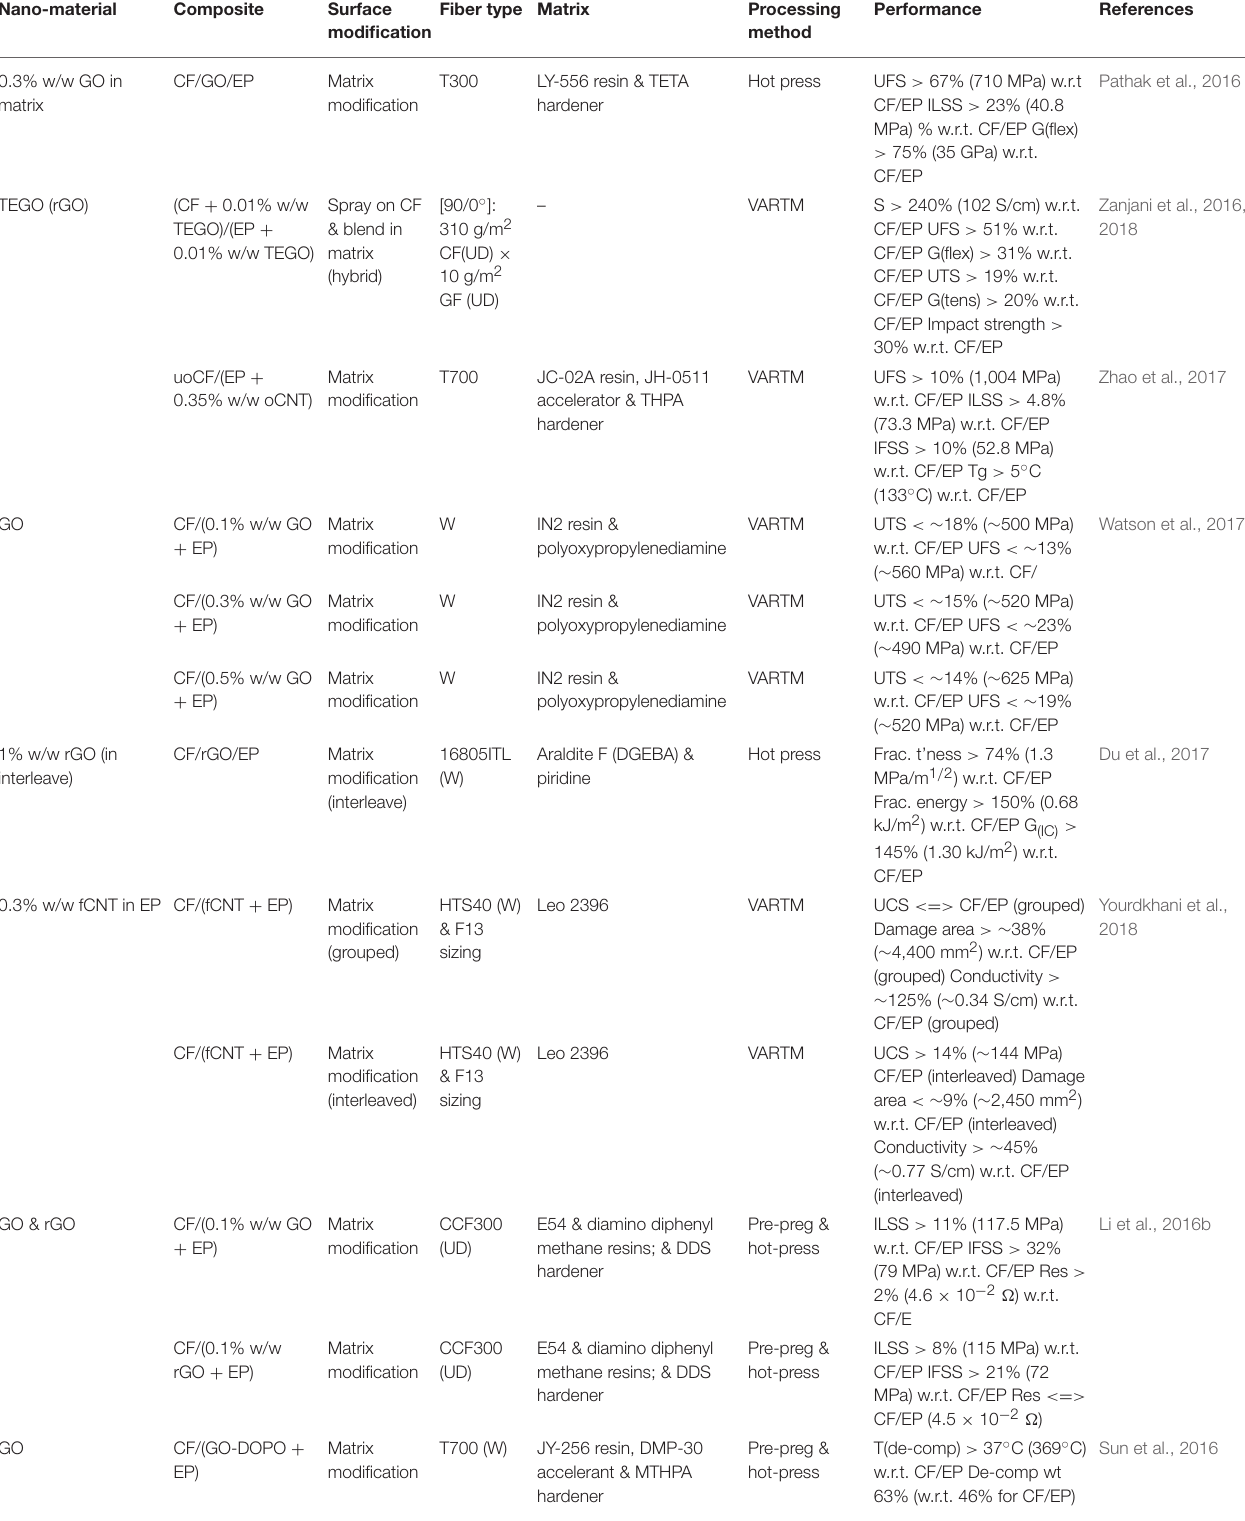
TABLE 4 | A summary of results from literature investigating the impact of resin matrix modifications on the properties of fiber-reinforced composites.